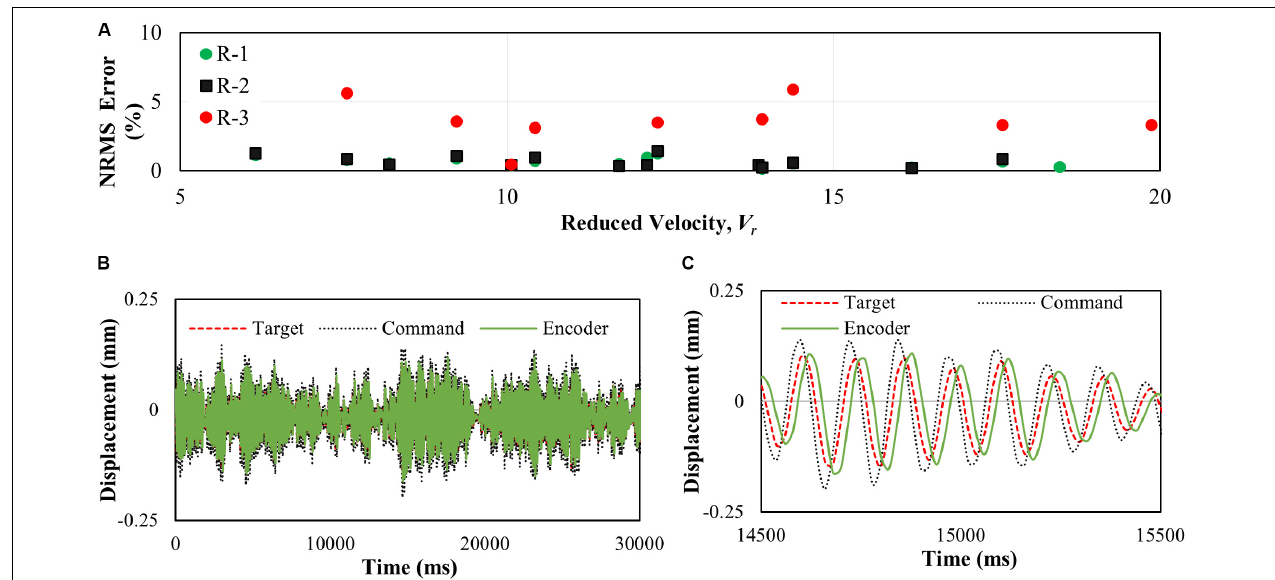
FIGURE 8 | Accuracy of the developed system. (A) Amplitude error, (B) time history for real-time hybrid simulation, (C) zoom-in view of time history for a real-time hybrid simulation.